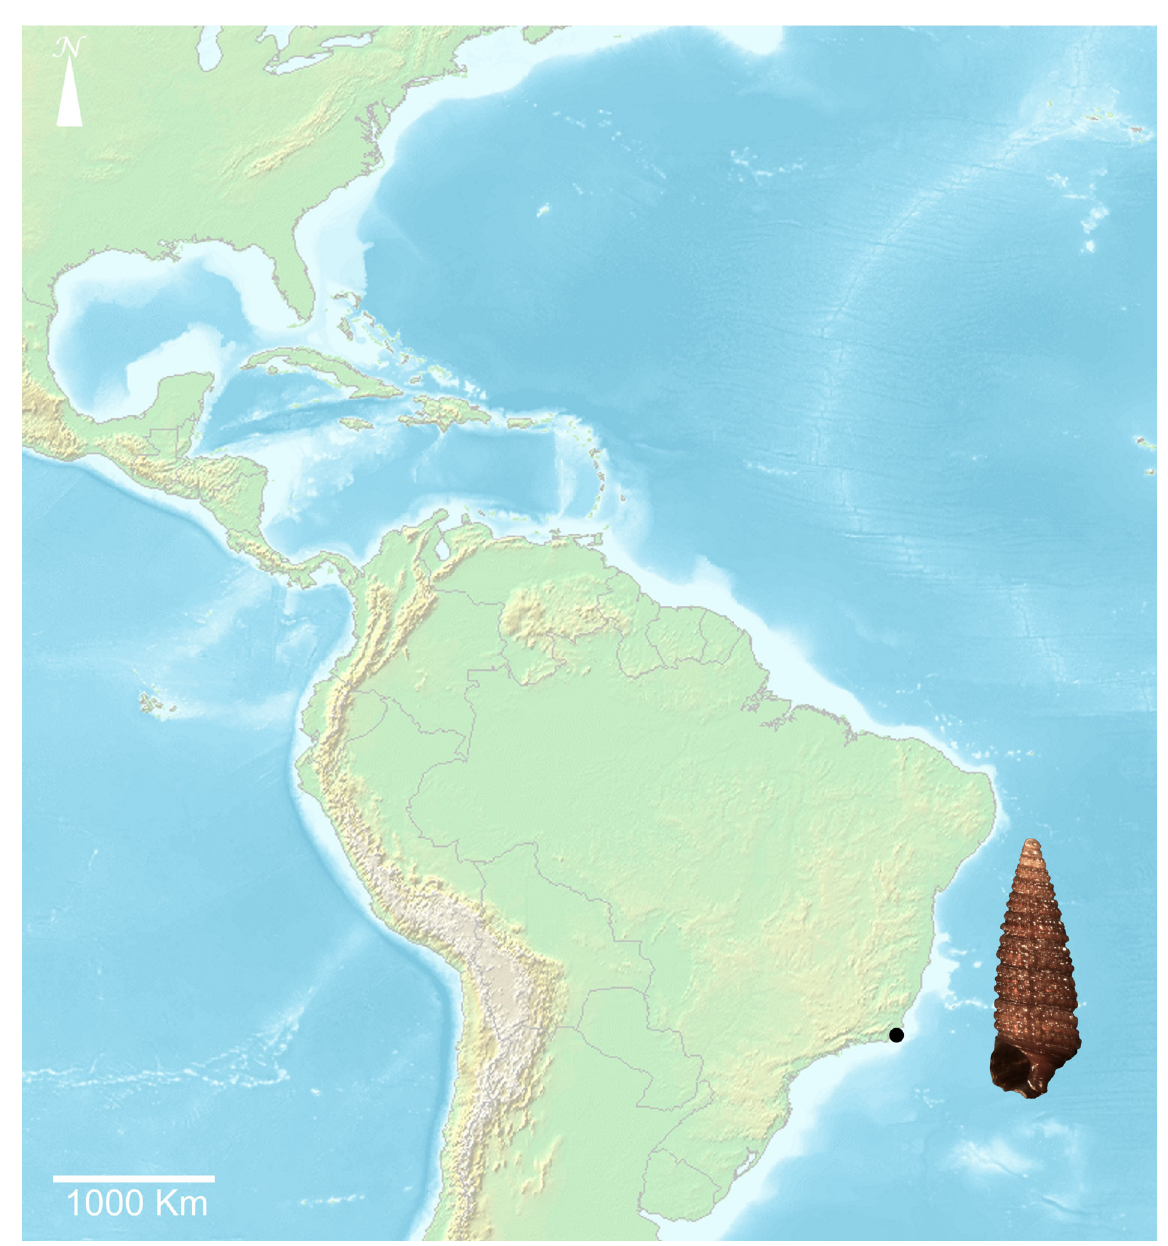
Fig. 55. Distribution map of Marshallora